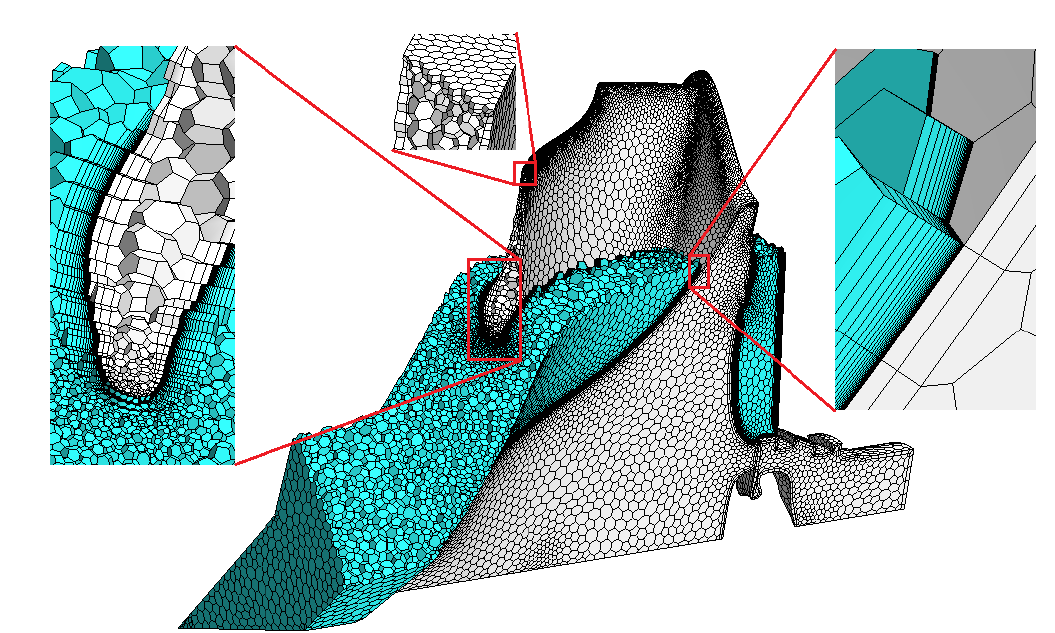
Figure 6. Mesh for CFD and